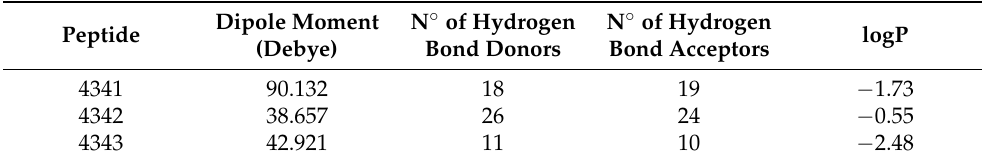
Table 1. Physicochemical and molecular descriptors for each peptide.